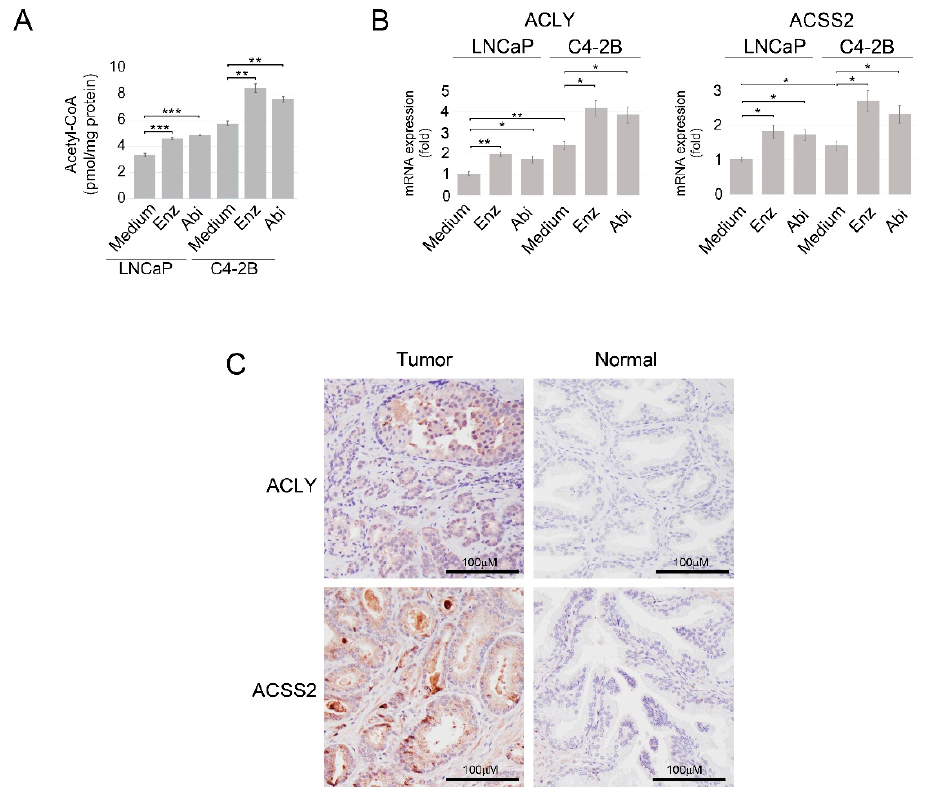
Figure 1. Treatment with enzalutamide and abiraterone increases intracellular levels of acetyl-CoA and promotes expression of ACLY and ACSS2 in PC cells. ( A ) LNCaP and C4-2B cells were cultured in RPMI 1640 medium supplemented with 10% FBS or treated with enzalutamide (Enz) or abiraterone (Abi) (both at 10 µ M) for 24 h. Intracellular levels of acetyl-CoA were examined as described in Materials and Methods. ( B ) LNCaP and C4-2B \ cells were cultured as described in Panel A. Gene expression was assayed by qRT-PCR. 18S gene was used for normalization. Results are expressed as the mean ( n = 3) ± SD. * p < 0.01; ** p < 0.001; *** p < 0.0001. ( C ) Representative images of primary moderately differentiated (Gleason score 7) prostate cancer and normal prostate tissue specimens stained for ACLY and ACSS2. The images were derived from a TMA composed of human at FCCC.